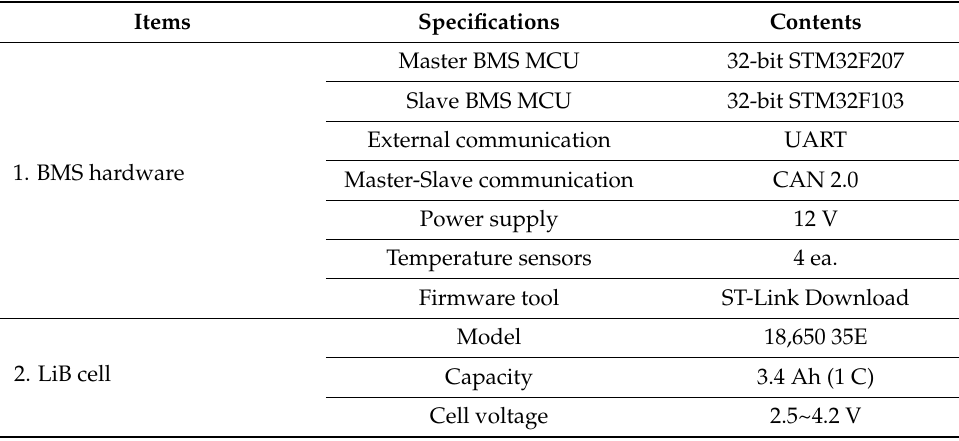
Table 1. Detailed specifications of the smart BMS and LiB pack.